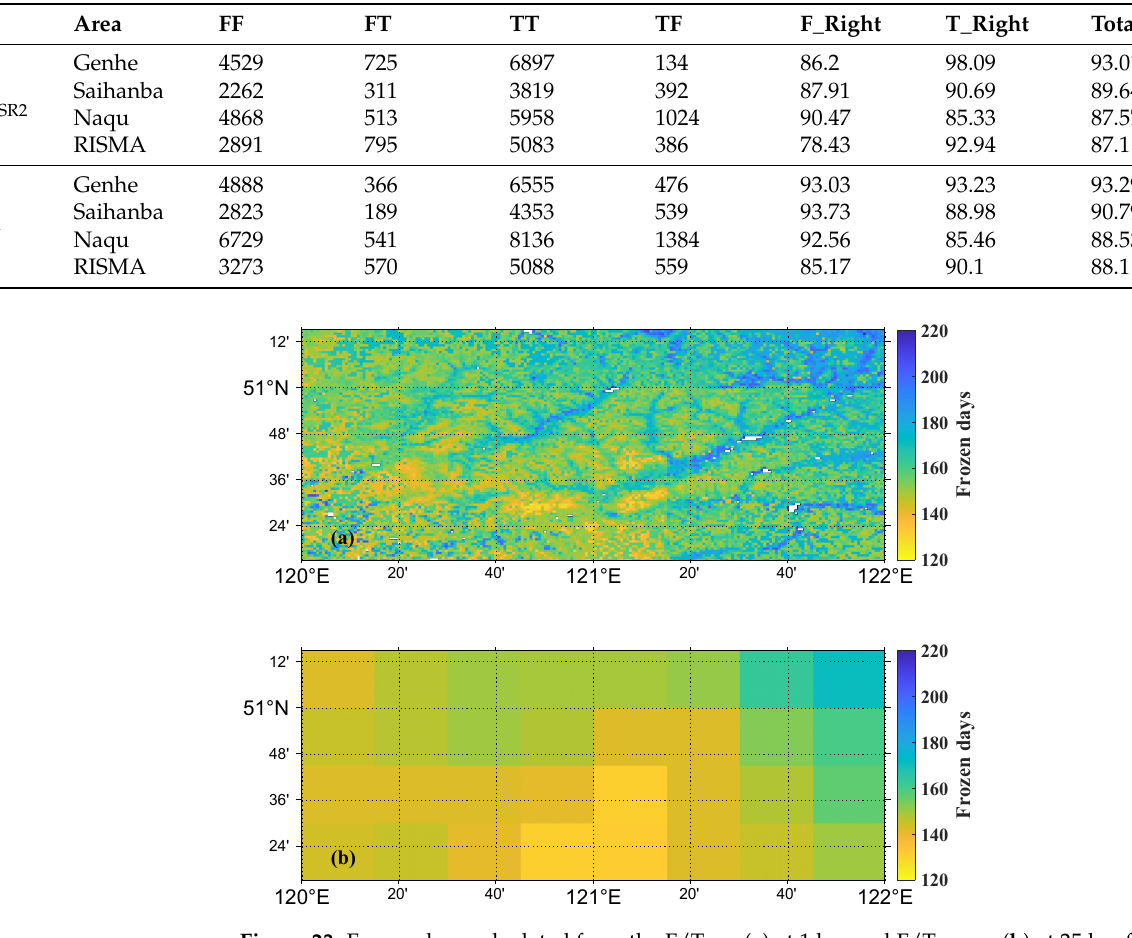
Figure 23. Frozen days calculated from the F/T new ( a ) at 1 km and F/T AMSR2 ( b ) at 25 km from June 2017 to May 2018. Table 8. Classification accuracy (%) statistics for F/T AMSR2 and F/T new .